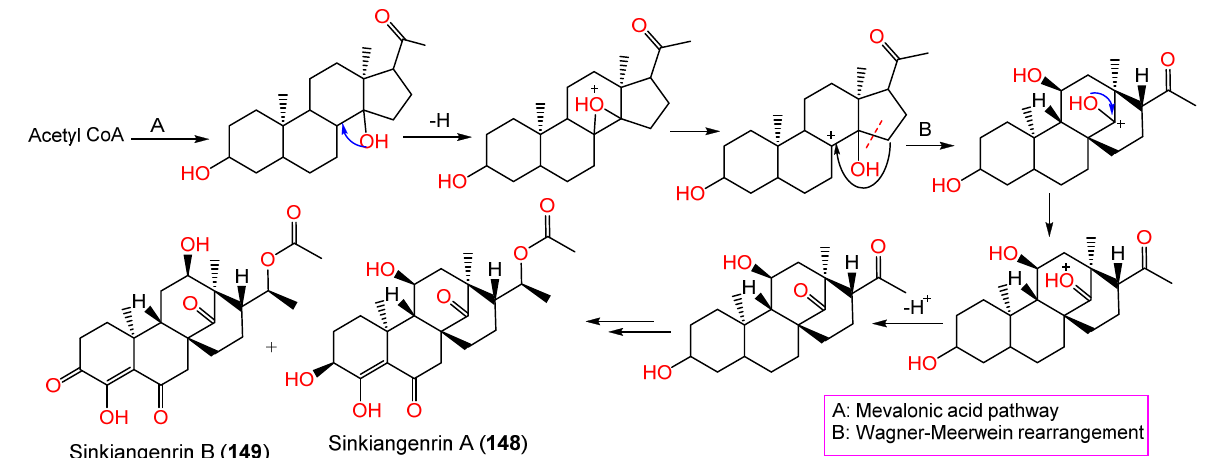
15 of 33 Figure 16. Structures of sulfanes ( 126 – 147 ) reported from F. sinkiangensis . 5.8. Sterols Chromatography separation of F. sinkiangensis 95% EtOH seed extract using SiO 2 , Se- phadex LH-20, and HPLC yielded new steroidal esters: sinkiangenrins A ( 148 ) and B ( 149 ) that were characterized by NMR and Xray analyses [17]. These compounds are related to oleagenin-cardenolide with different C-13/C-10/C-9/C-8 configuration, having 3S/8R/9S/10S/11S/13S/17R/18R and 8S/9S/10S/12R/13R/17R/18R-configurations, respec- tively (Figure 17). Figure 17. Structures of sterols ( 148 – 153 ) reported from F. sinkiangensis . These metabolites have an unparallel carbon framework that originates from C21- steroids (Scheme 3). Firstly, the initiation of D-ring rearrangement by C8–C14 pregnane